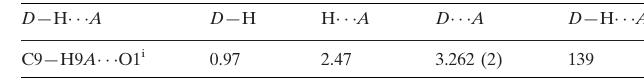
Hydrogen-bond geometry (A˚ , (cid:2)